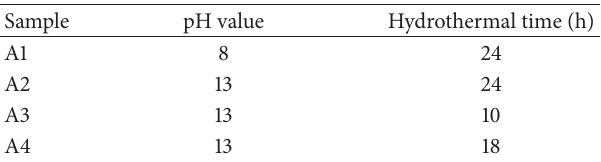
Table 1: The hydrothermal conditions of each sample. Sample pH